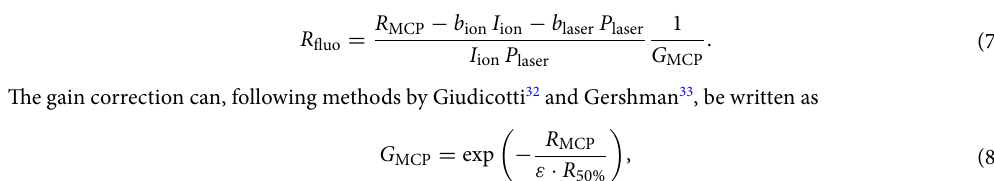
Figure 6. Left: Observed resonance curve for the Measured resonance voltages as a function of the cooler current for the